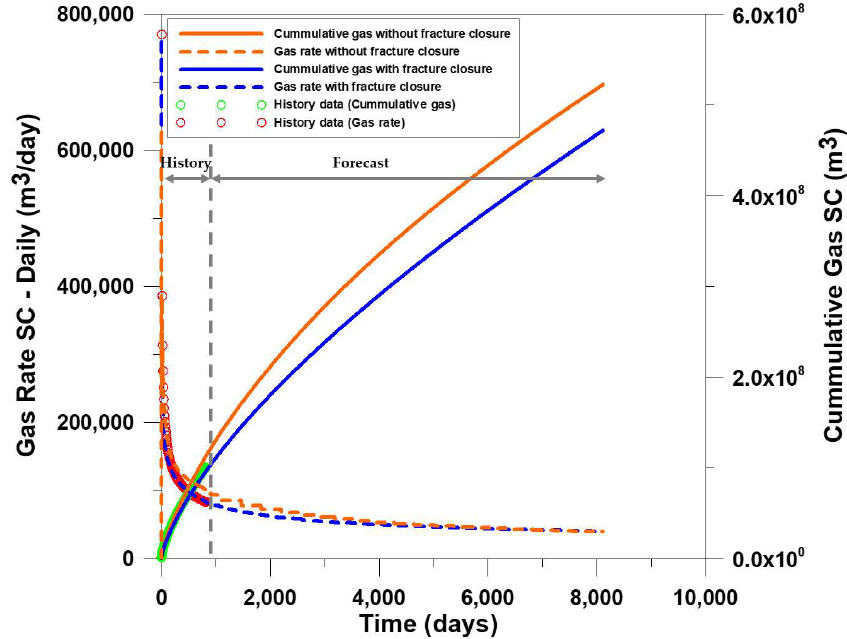
Figure 18. Comparison of production forecasting results with consideration of changes in hydraulic fracture width. fracture